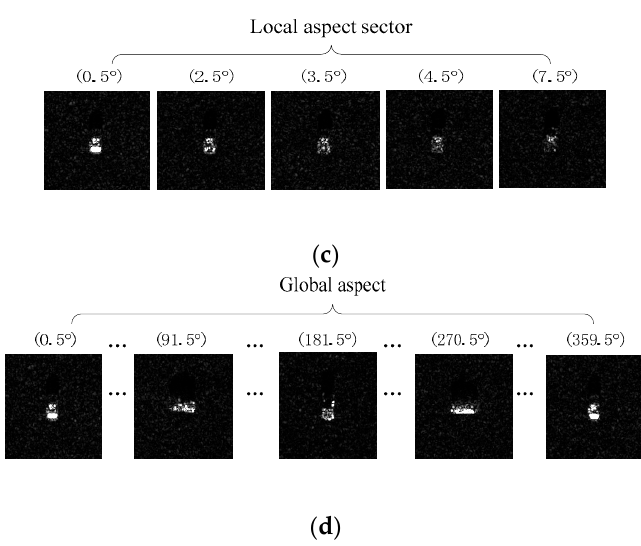
Figure 1. ( a ) Description of aspect angle and depression angle in radar sensor. ( b ) Top view of aspect. ( c ) SAR target images in local aspect sector. ( d ) SAR target images in global aspect.